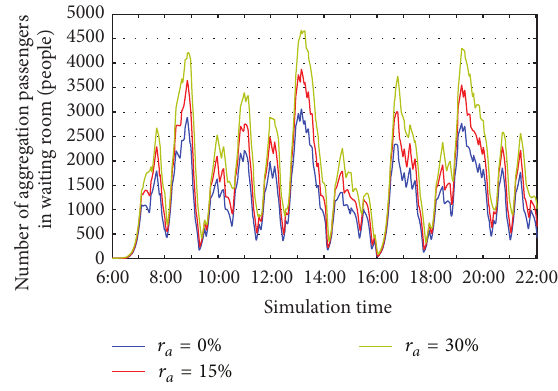
Figure 8: The number of aggregation passengers varies over the values of the accompany